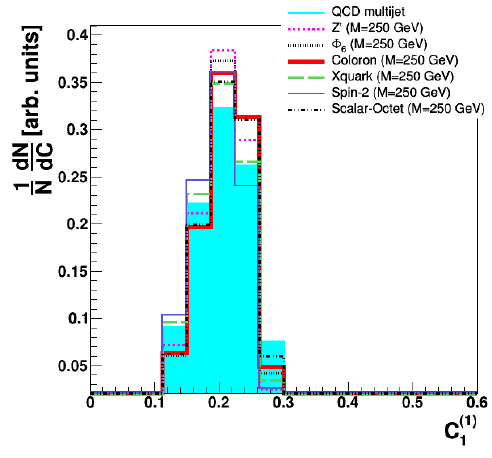
Figure 1 . The double ratio distribution for C (1) for the di(cid:11)erent kinds of resonances under con- 1 sideration; Z 0 in pink (small-dashed), sextet-diquark (cid:8) 6 in black (dotted) , Coloron ( C (cid:22) ) in red (bold,thick), excited quark ( q ? , Xquark) in green (large-dashed), Spin-2 ( X (cid:22)(cid:23) ) in blue (bold,thin), scalar color octet ( S 8 ) in black (dot-dashed) . The cyan shaded region corresponds to the distribu- tion of the multi-jet background.